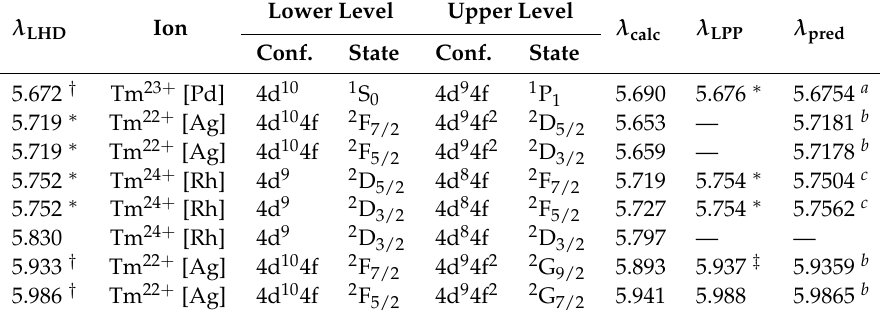
Figure 2. Soft X-ray spectrum of thulium ions recorded in an LHD plasma under a low-temperature condition (top panel) and the line strength ( gA values) distribution of 4d–4f transitions of Tm 22 + –Tm 24 + ions calculated by Cowan code (bottom panel). The peak electron temperature for the LHD spectrum is approximately 0.7 keV. The assignments of the spectral lines indicated by arrows are summarized in Table 4. Table 4. The assignments of the lines of thulium ions indicated by arrows in the top panel of Figure 2. The assignments are based on a comparison with the Cowan code calculation. Isoelectronic sequence of each ion is shown in a square bracket. The states of the lower and upper levels are denoted in LS coupling notation. All wavelengths are in nm. The wavelengths measured in the LPP ( λ LPP ) [15] and the wavelengths predicted in the earlier studies ( λ pred ) are listed in the last two columns. References: a [47], b [48], c